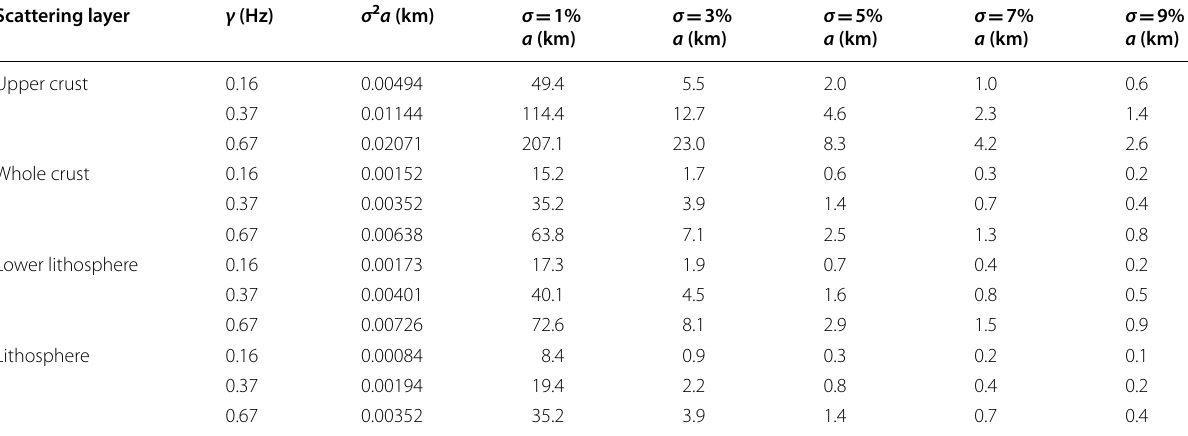
1–9% for four different scattering layers taken from Table 1 =